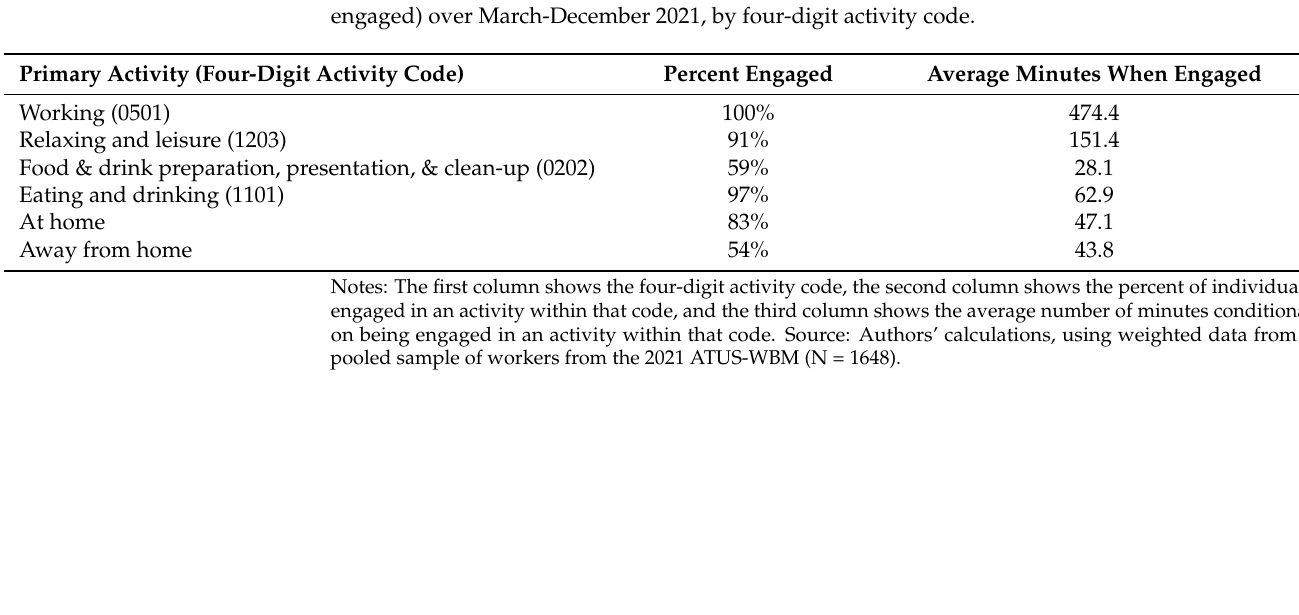
Table A2. Share of working individuals who engaged in an activity (and average minutes